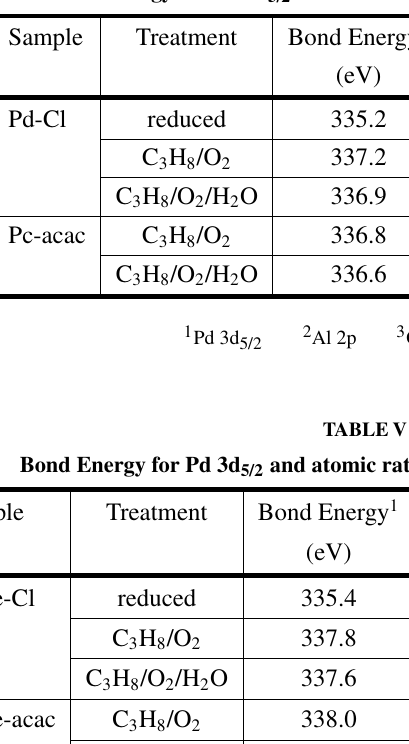
Bond energy for Pd 3d 5/2 and atomic ratios by XPS for Pd/Al 2 O 3 .